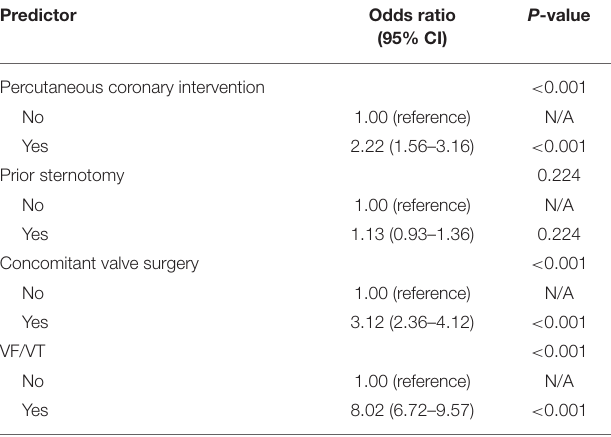
TABLE 4 | Multivariable analysis for predictors of in-hospital mortality, 2015–2016.